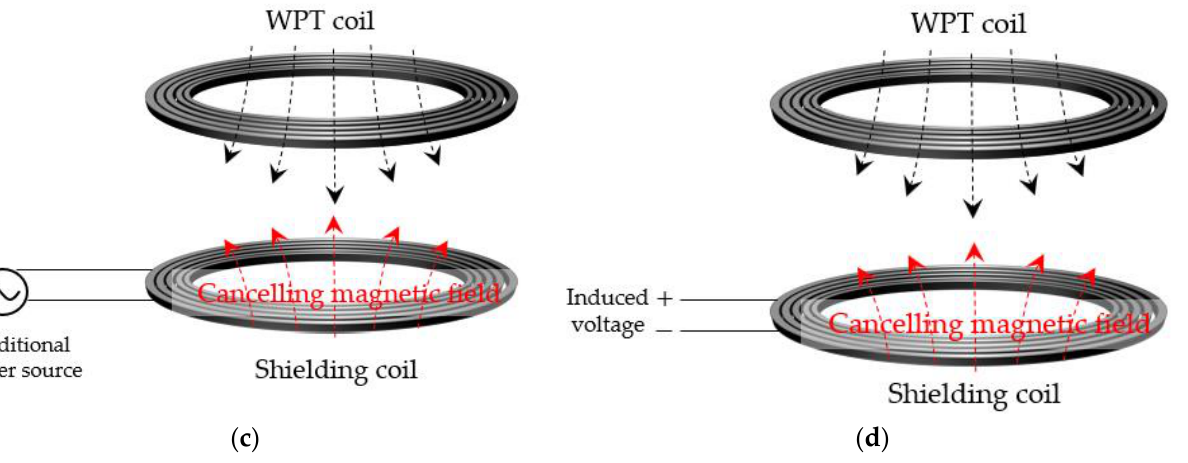
Figure 2. Various shielding methods used in WPT System: ( a ) metallic shielding; ( b ) magnetic shielding; ( c ) active shielding; ( d ) reactive shielding.